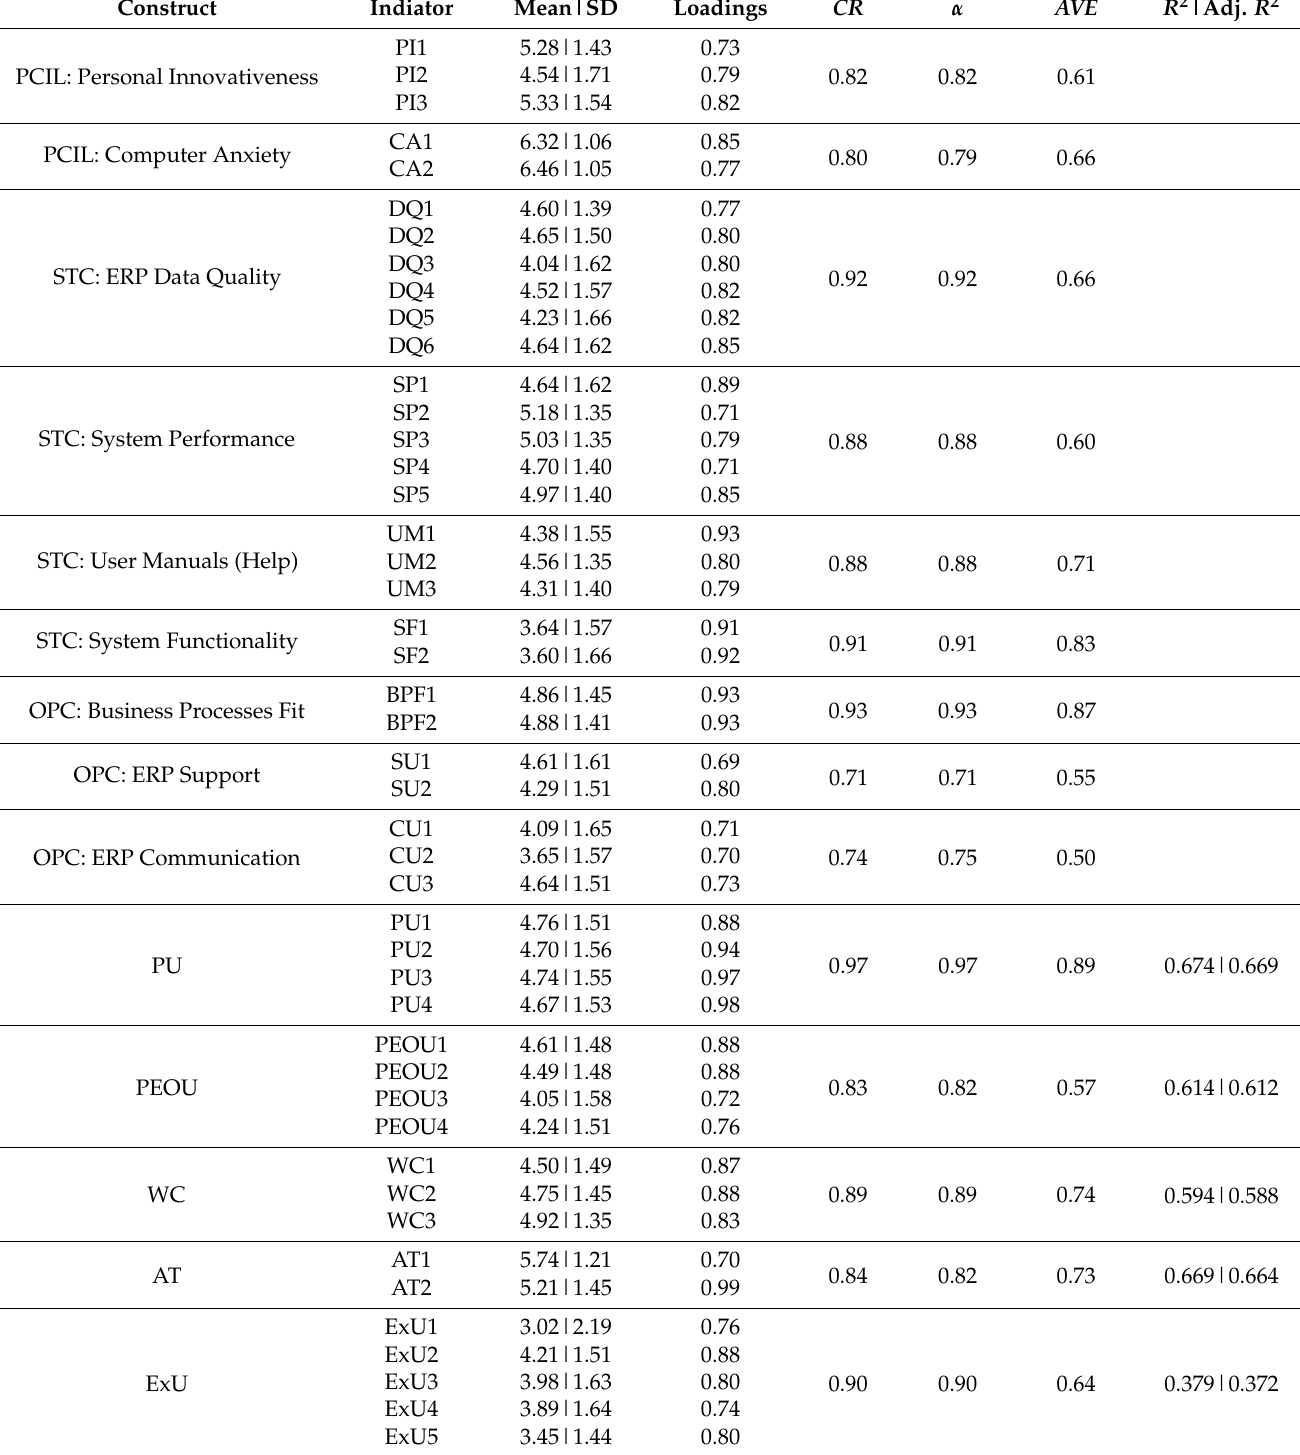
Table 3. Psychometric properties of the research instrument (sample size =